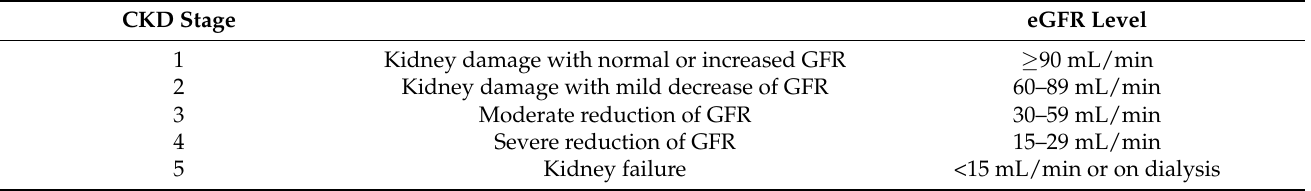
Table 1. Stages of chronic kidney disease and eGFR